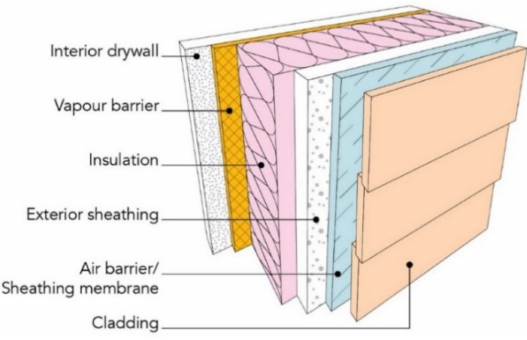
Figure 1. Typical multi-layer building